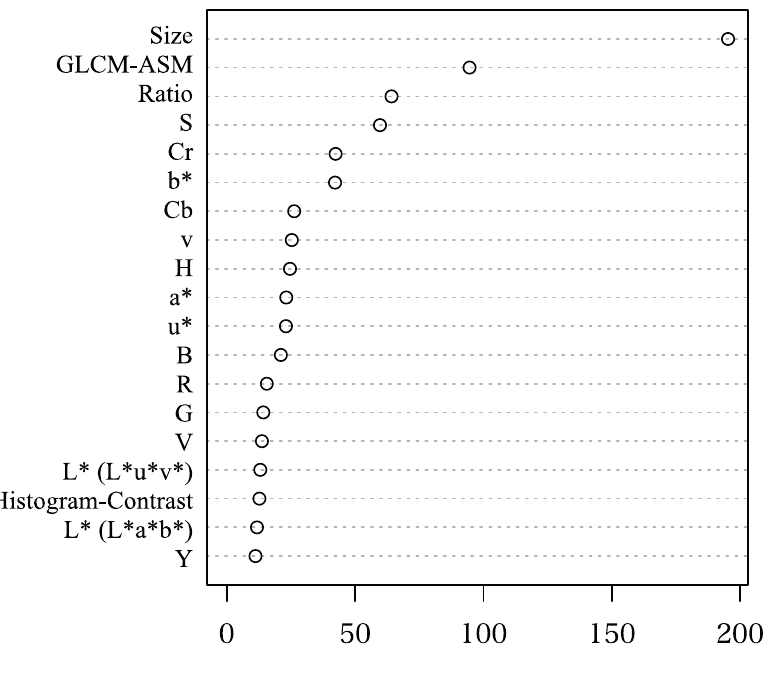
Figure 9. Importance of features based on the classification of blobs using the random forest classifier during blob-based segmentation. The horizontal axis shows the mean decrease Gini, which provides an indication of the importance of